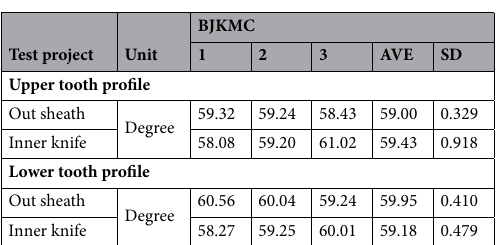
Table 2. Tooth profile and angle of BJKMC’s